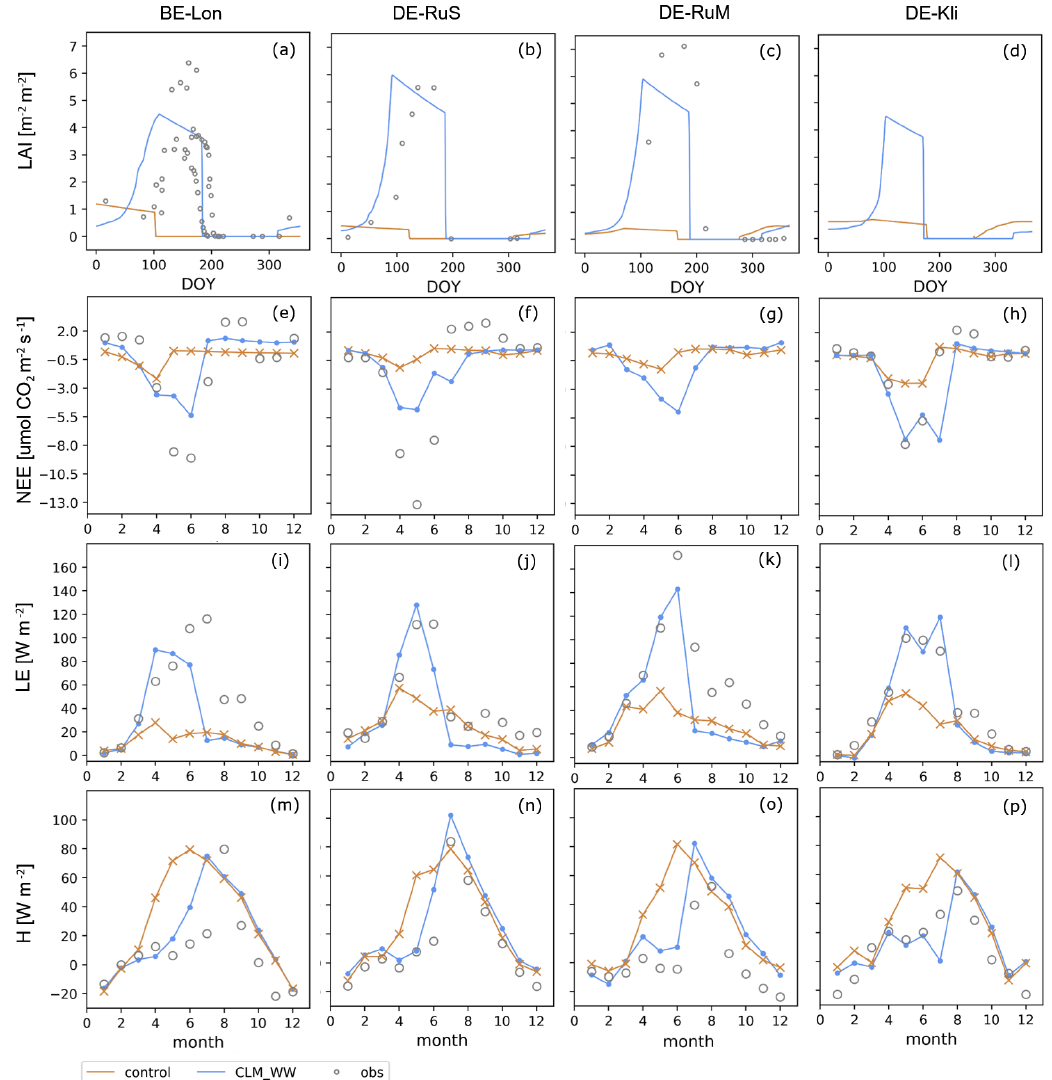
Figure 3. Simulation results of (a–d) LAI, and simulation results averaged for each month of (e–h) NEE, (i–l) LE, and (m–p) H for all winter wheat years (see Table 3) at the sites (from left to right) BE-Lon, DE-RuS, DE-RuM, and DE-Kli. Simulation results from the new routine with crop-specific parameterization (CLM_WW; blue) are compared to control simulations (orange) and available site observations (grey) of LAI (all available point observations plotted) and fluxes (averaged over all respective years and for each month, respectively). Corresponding performance statistics for daily simulation results during the crop growth cycle are listed in Table